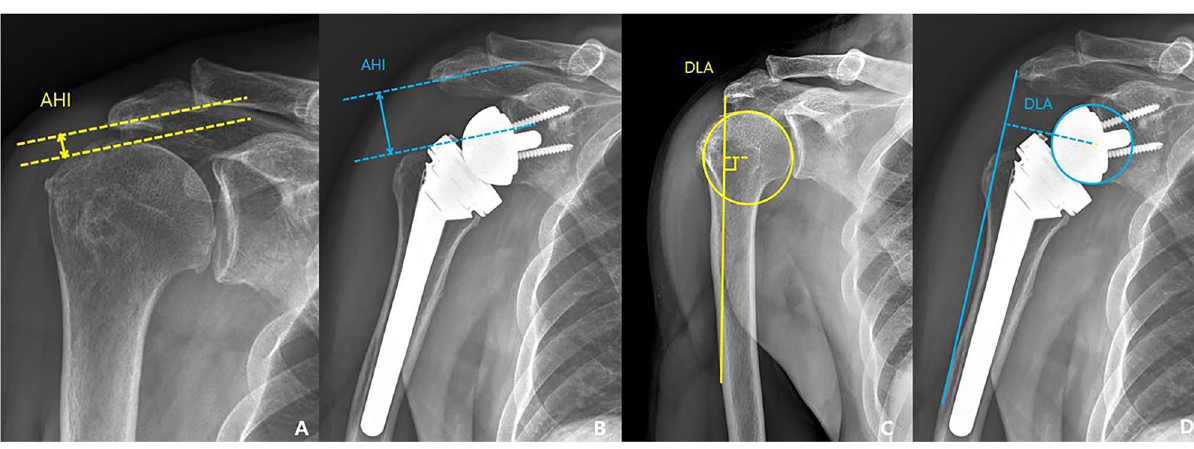
Figure 3. ( A ) preoperative acromiohumeral interval, ( B ) postoperative acromiohumeral interval, ( C ) preoperative deltoid lever arm, ( D ) postoperative deltoid lever arm.